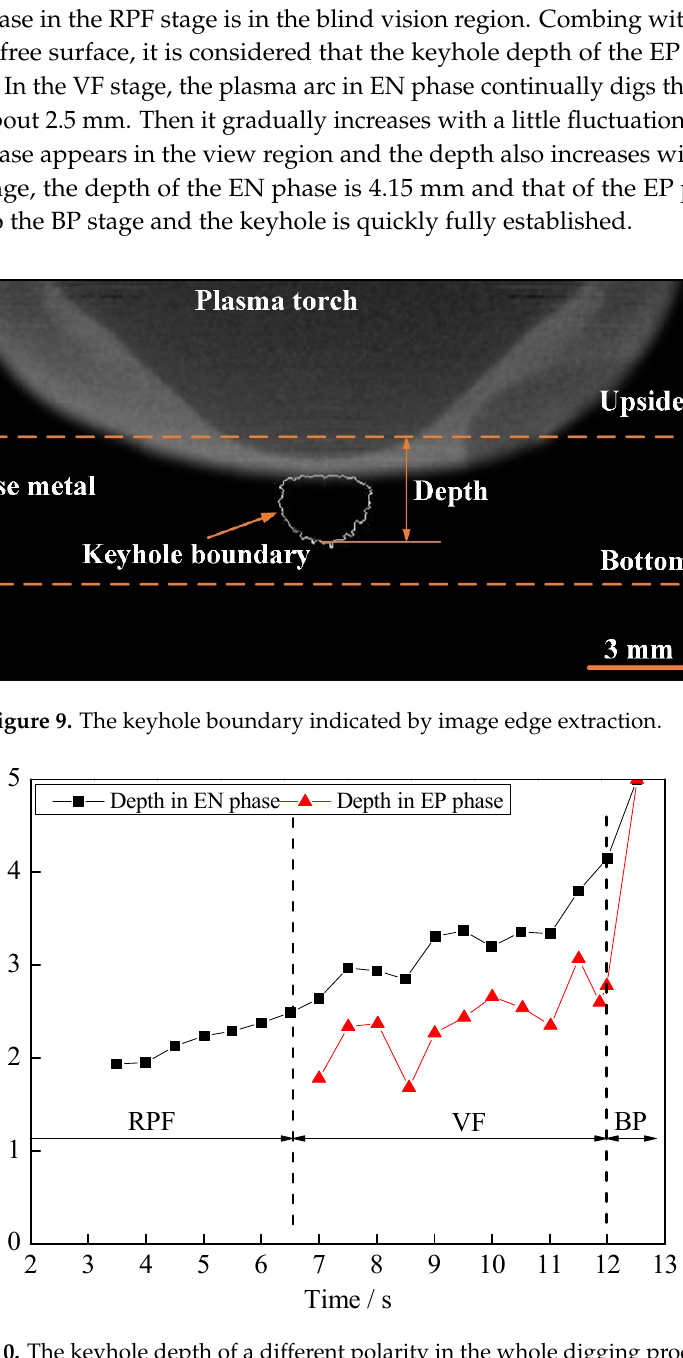
Figure 10. The keyhole depth of a different polarity in the whole digging process.